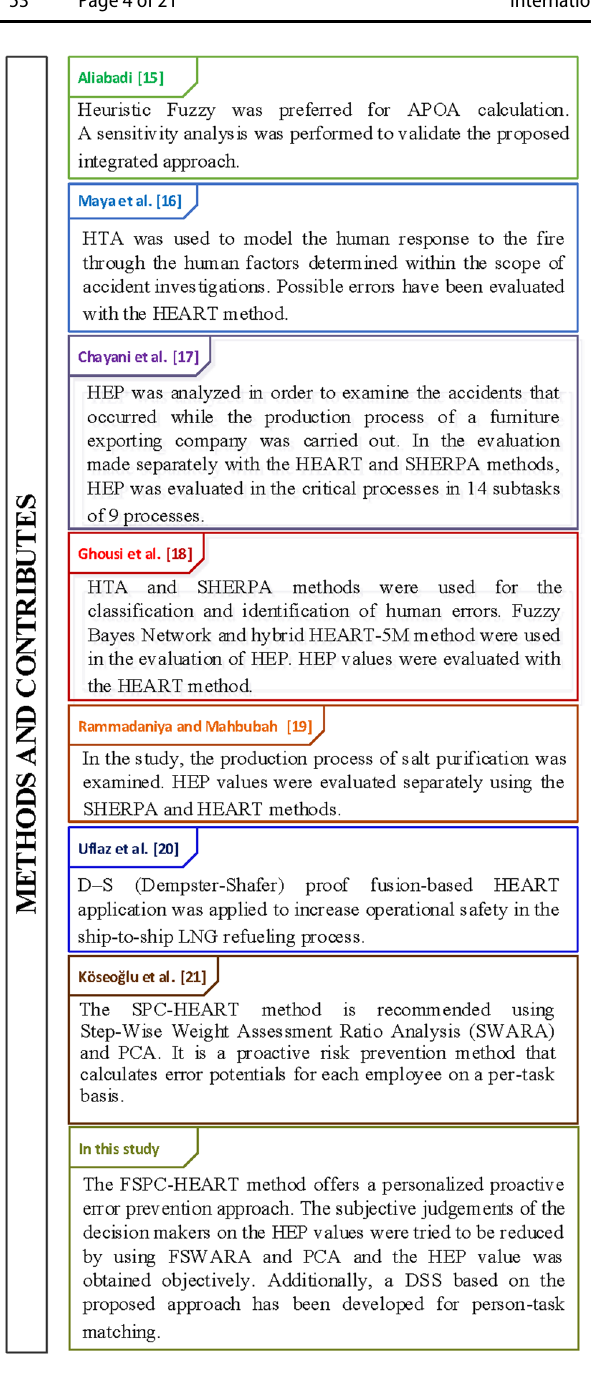
Fig. 1 Literature review for HEART